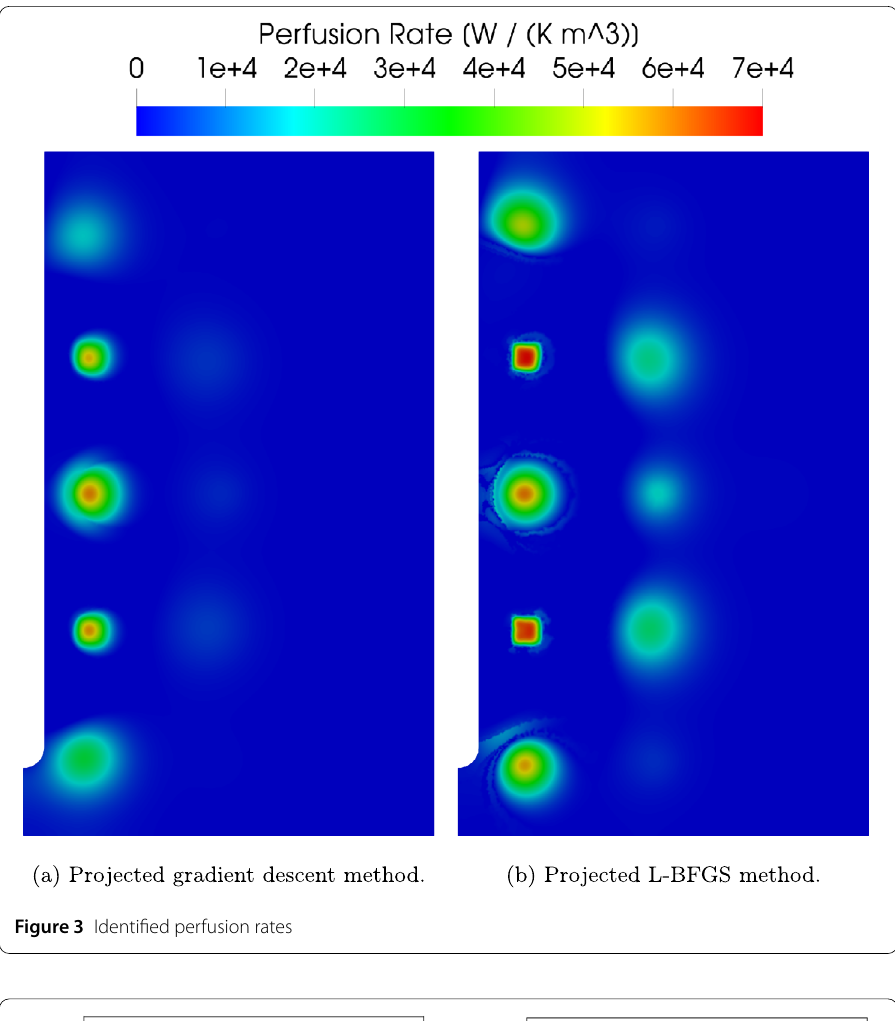
Figure 3 Identified perfusion rates